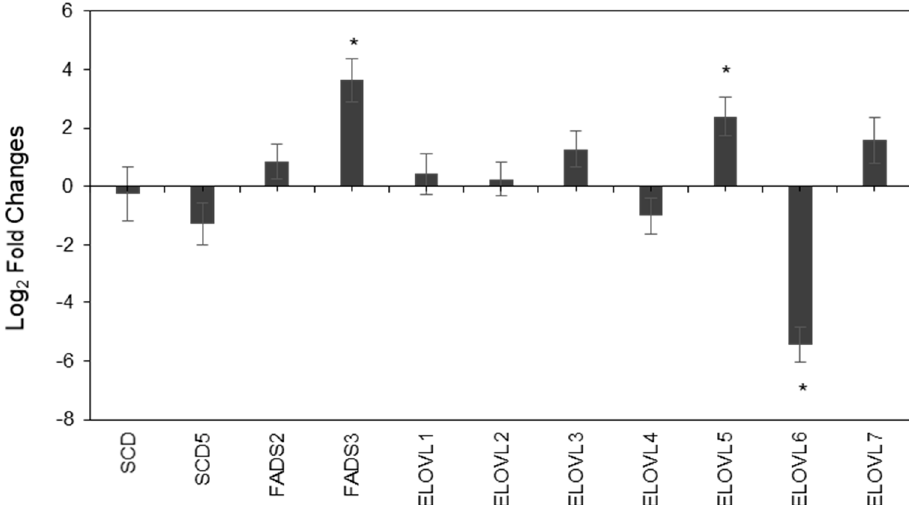
Figure 2. Evaluation of desaturase and elongase expression in PC3 cells by qRT-PCR (quantitative real Time polymerase chain reaction). X-axis presents 4 desaturase and 7 elongase enzymes. Y-axis represents the log2 (fold-change) of PC3 with respect to LNCaP cells. Fold-change was calculated by the comparative CT method ( ΔΔ CT) using glyceraldehyde 3-phosphate dehydrogenase ( GAPDH) as control for Δ C t and calculating ΔΔ Ct by subtracting Δ C t for PC3 to Δ C t for LNCaP.